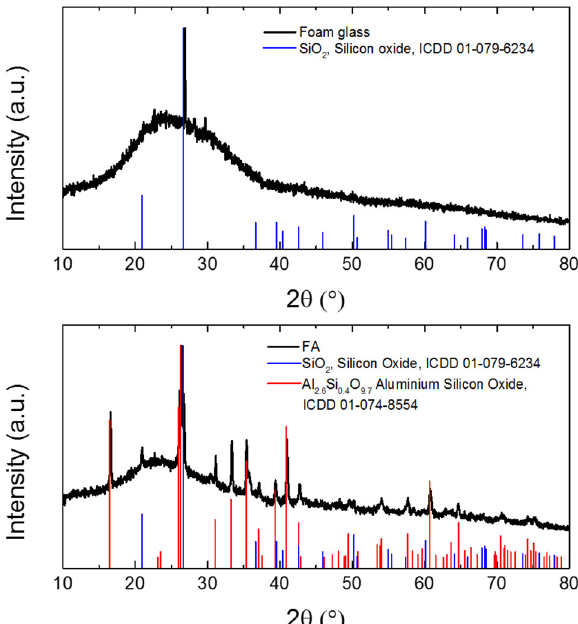
Figure 1. X-Ray diffraction of foam glass and fly ash. Figure 1. X-ray diffraction of foam glass and fly ash. The grain size curves of both used aggregates, i.e., of quartz sand and foam glass, are presented in Figure 2. Both materials exhibited a similar maximum size of particles. Apparently, foam glass granules were considerably finer compared to silica sand